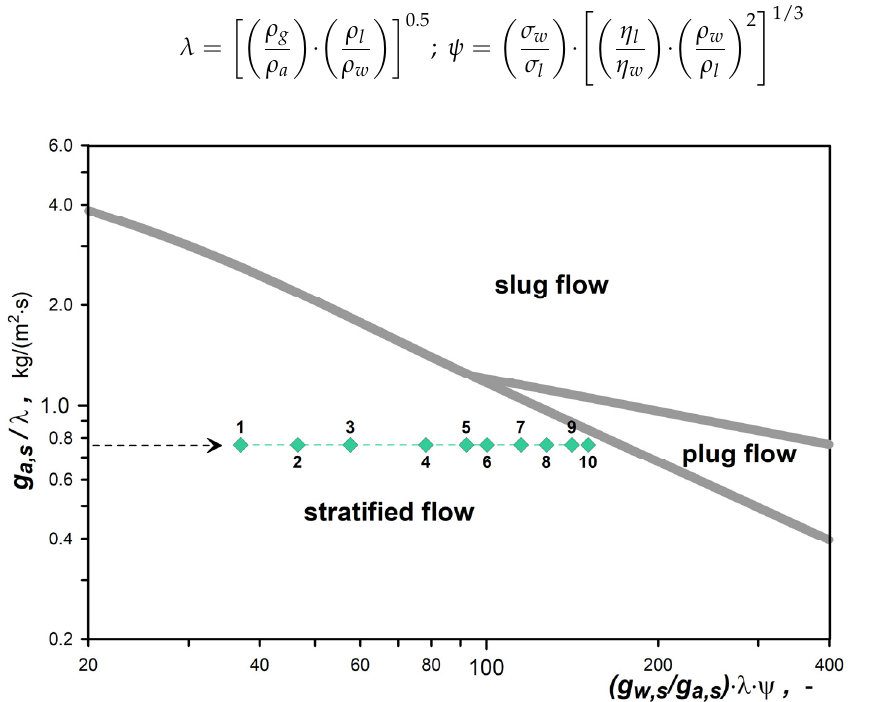
Figure 4. Section of Baker’s map with a marked measurement series projected in this study.